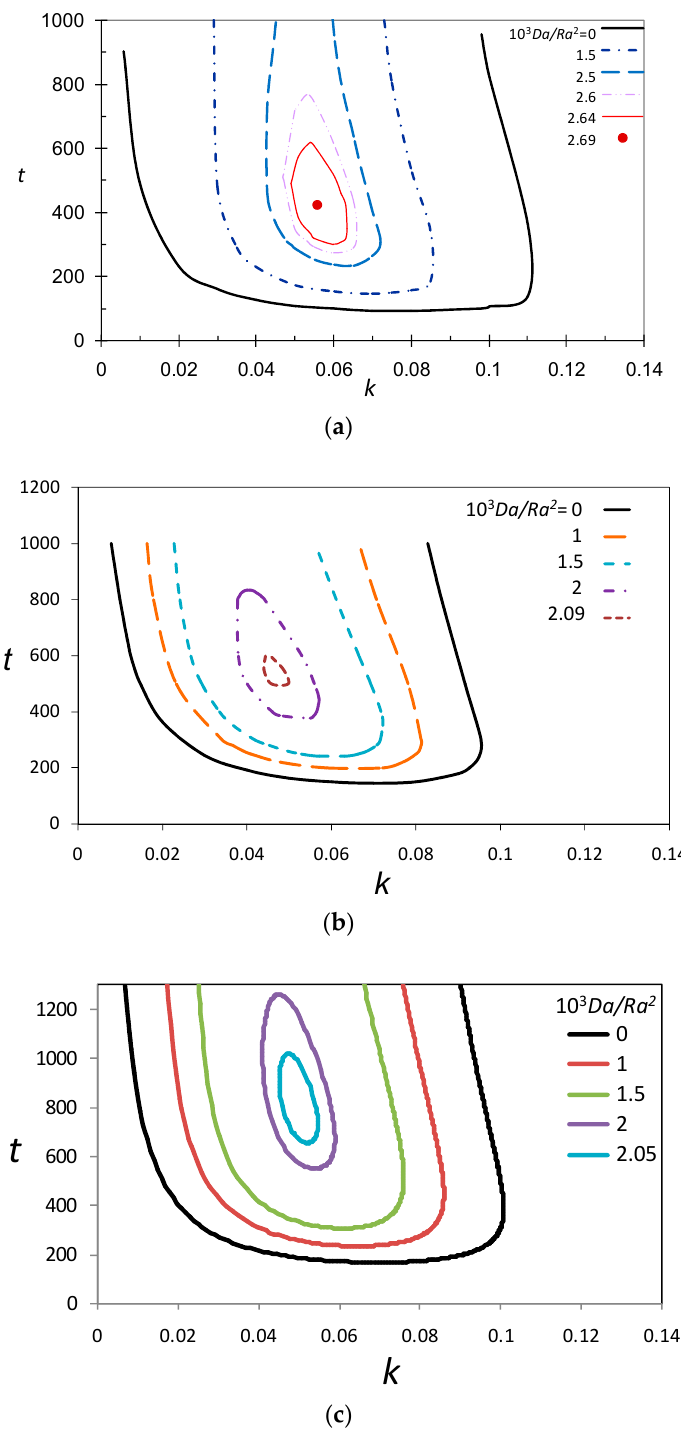
Figure 6. Effect of a precipitating reaction on the marginal stability boundary using ( a ) an initial-value problem approach [7]; ( b ) the dominant mode analysis; and ( c ) the quasi-steady state assumption (QSSA) method.